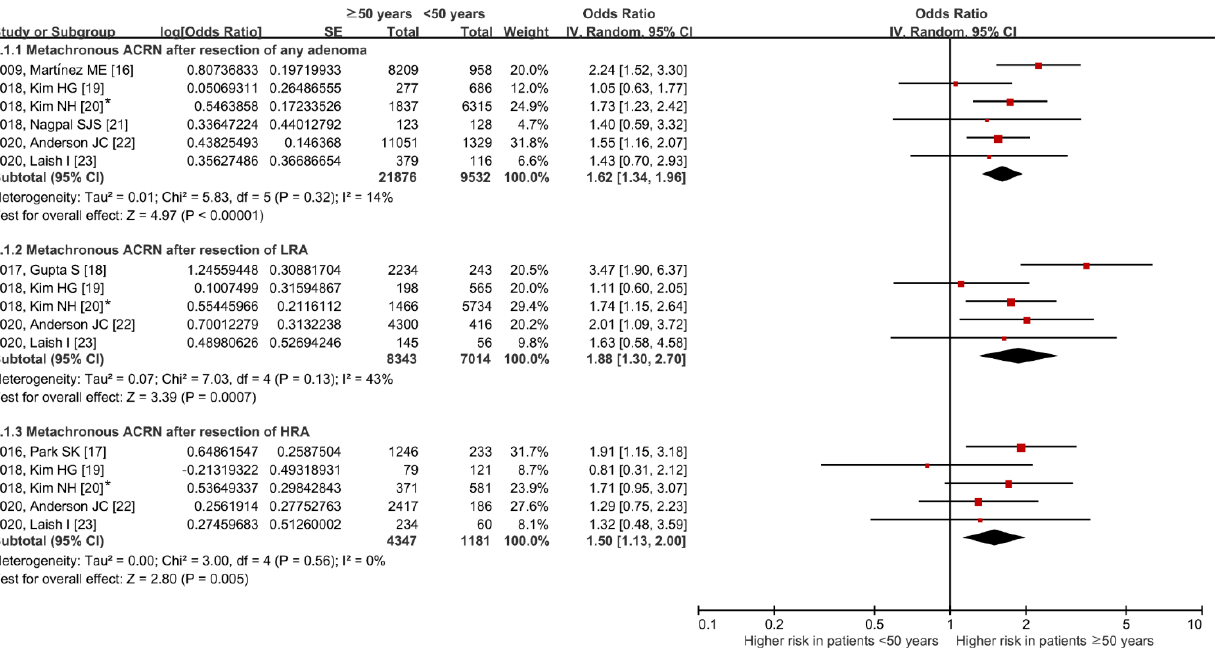
Figure 3. Comparative risk of metachronous ACRN between age groups according to the index colonoscopy finding groups. * Values in this study were provided by the corresponding author. ACRN, advanced colorectal neoplasia; LRA, low-risk adenoma; HRA, high-risk adenoma; SE, standard error; IV, inverse variance; CI, confidence interval.